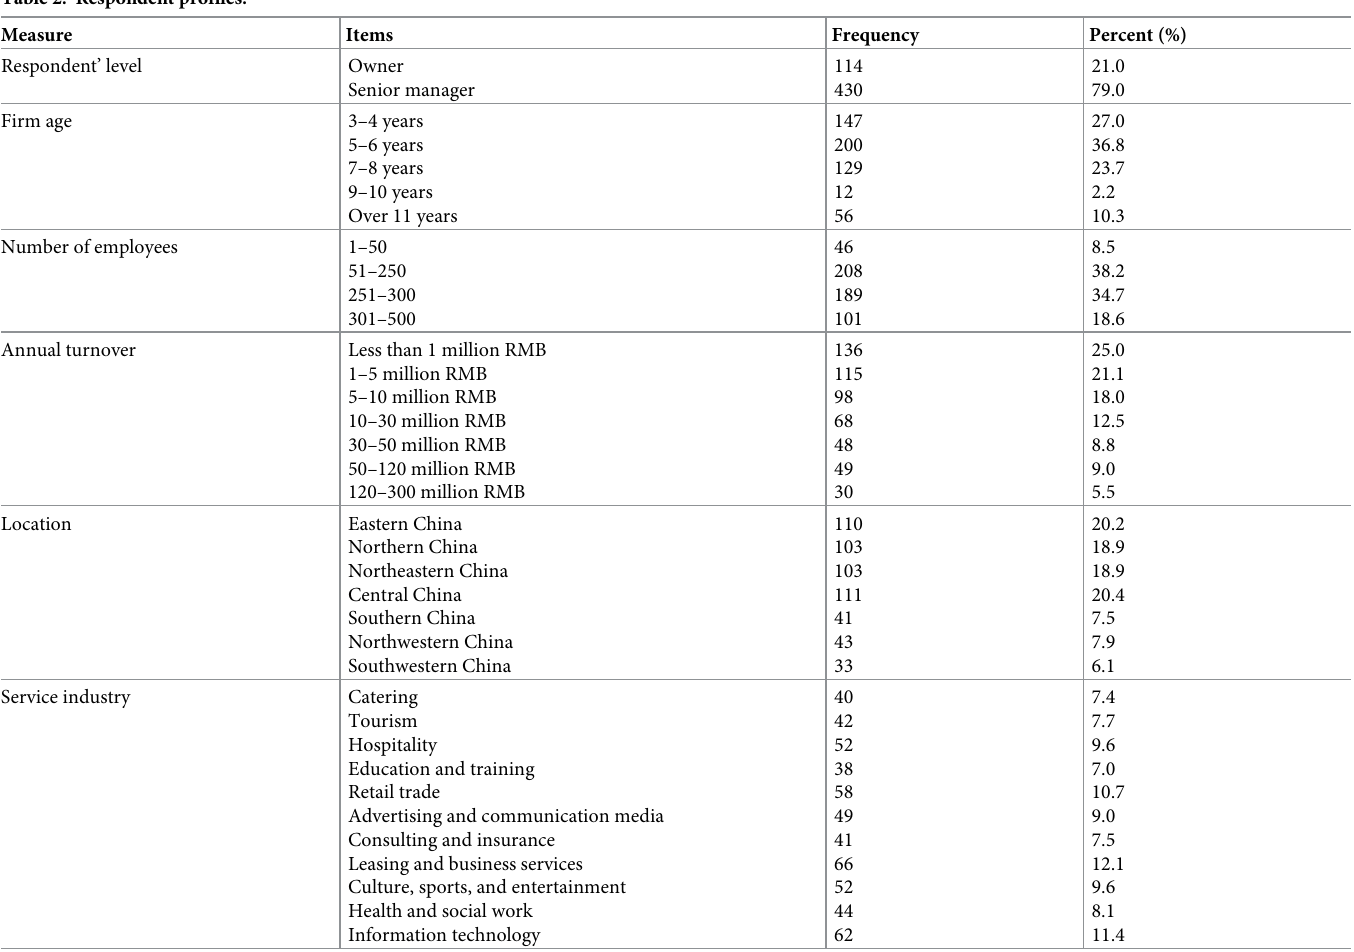
Table 2. Respondent